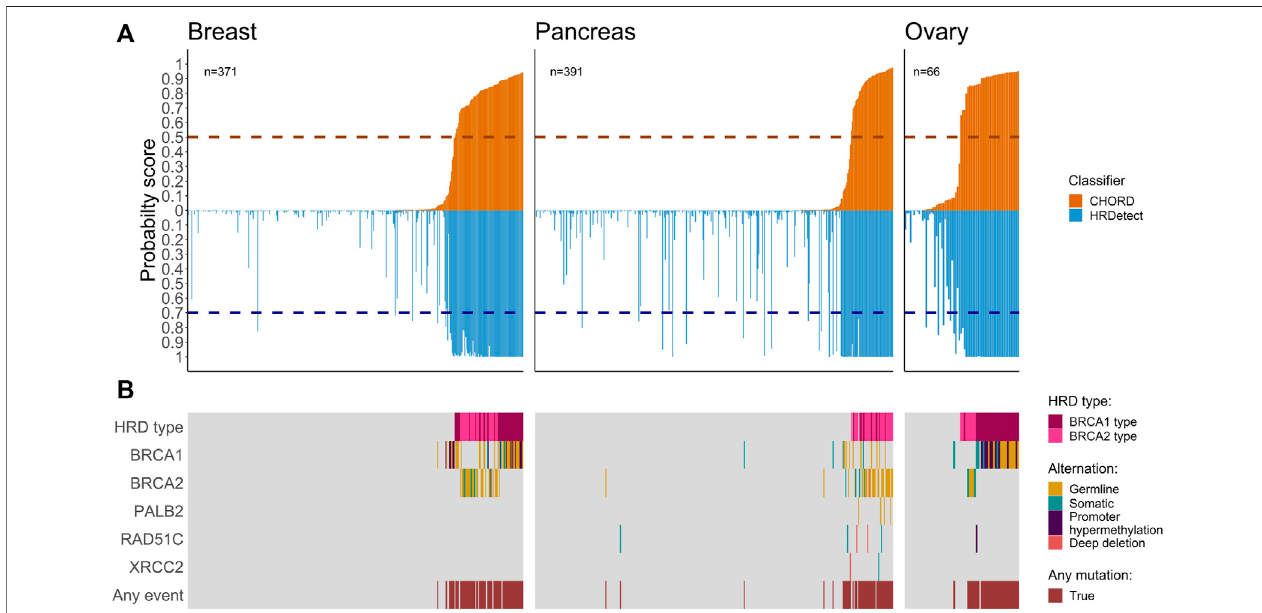
FIGURE1| Co-mutationplotsforbreast,pancreas,andovariancancers. (A) MirrorbarplotshowingtheprobabilityscoreofCHORD(orange)andHRDetect(blue) classi fi ersforeachsamplealongsidethedefaultthresholdvalueforeachclassi fi er(horizontaldashedline,0.5forCHORDand0.7forHRDetect).Samplesareorderedby the CHORD probability score from the lowest to the highest. (B) The biallelic inactivation in genes related to HR de fi ciency. HRD types ( BRCA1 and BRCA2 types) were assigned by the CHORD classi fi er.